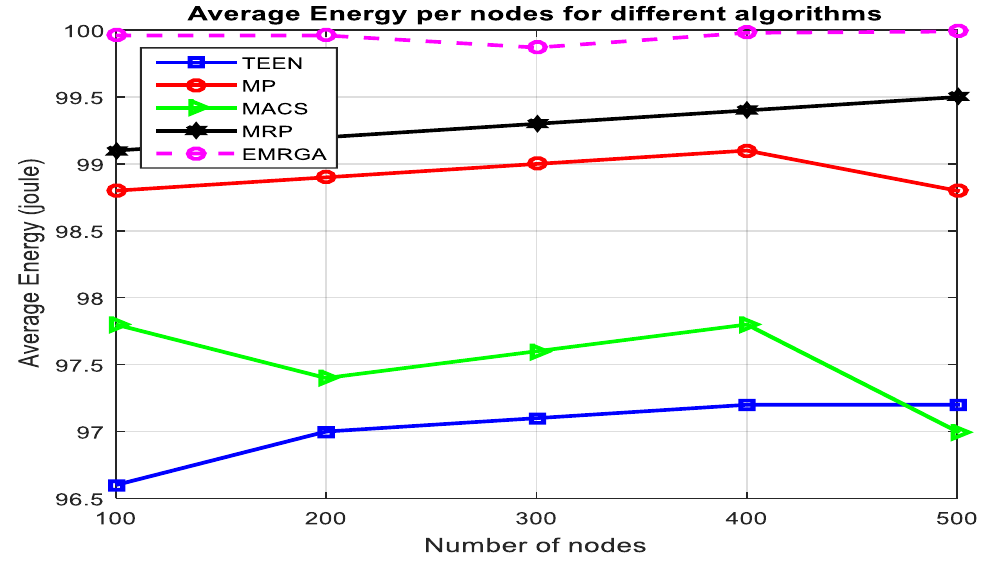
Figure 5. Average residual energy.